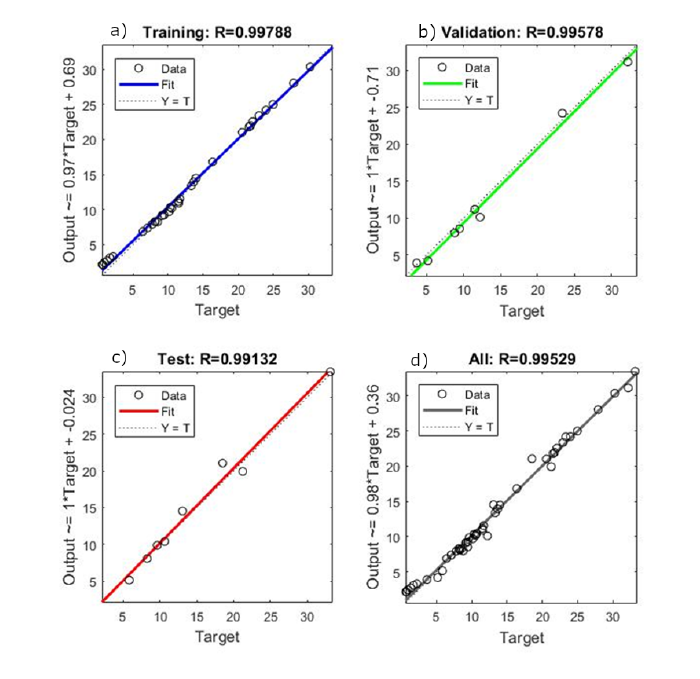
Figure 7. Regression and correlation of the harvested area using Matlab